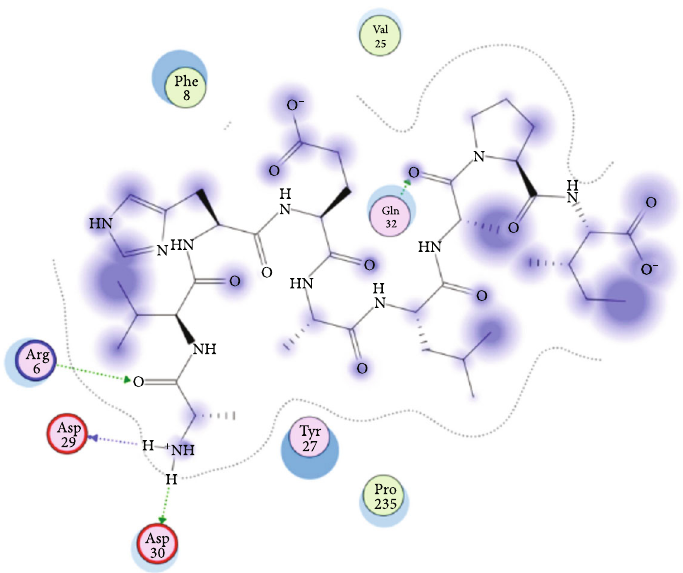
Figure 10: Illustration of the 2D interaction of the best docking poses of AVHEALAPI in the binding sites of HLA-A ∗ 02:06.